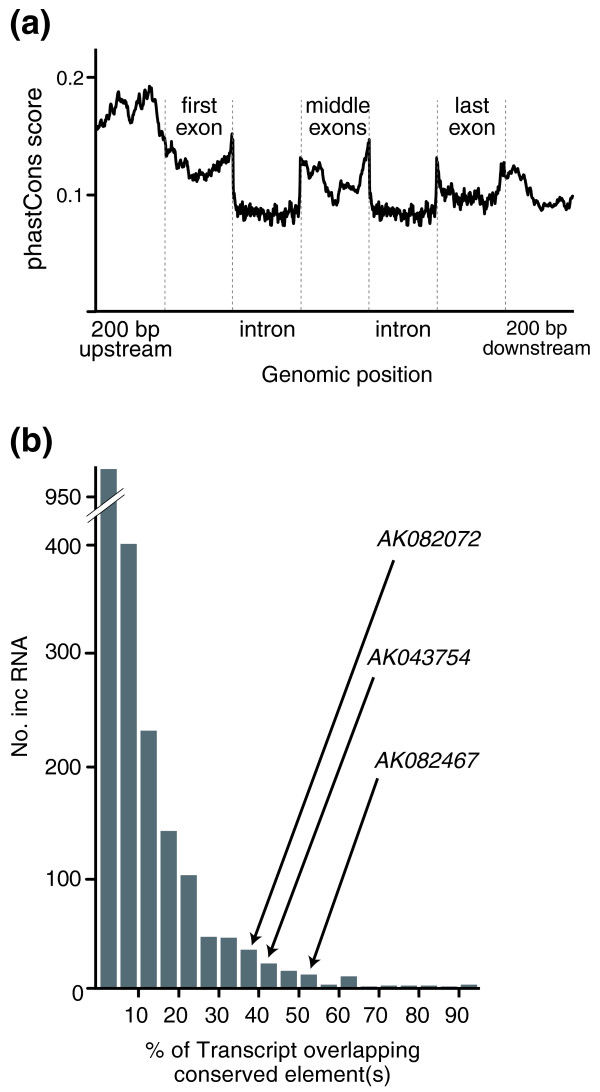
Sequence conservation among lncRNAs. (a) Conservation across a generic lncRNA locus, based on 877 mouse multi-exon lncRNAs. We sampled 200 evenly spaced bases across each region listed, with regions containing fewer than 200 bases sampled entirely. The graph shows the average vertebrate phastCons score at each genomic position across all multi-exon lncRNA loci. Note phastCons score peaks within the putative promoter region (200 bp upstream) and near donor and acceptor splice sites (analysis inspired by Figure 25a in [31]). (b) Overlap between vertebrate phastCons-predicted conserved elements and mouse lncRNA exons. Of 2,055 lncRNAs with signatures of purifying selection initially identified in mouse [18], 1,095 contain exons that overlap phastCons-predicted vertebrate conserved elements (log-odds score range 1 to 1,000) [30]. Depicted is a histogram showing the percentage of each lncRNA transcript that overlaps a phastCons-predicted vertebrate conserved element. The relative positions of three selected lncRNAs (AK082072, AK043754, and AK082467 with overlaps of 36.7, 44.8, and 51.7%, respectively) are shown.